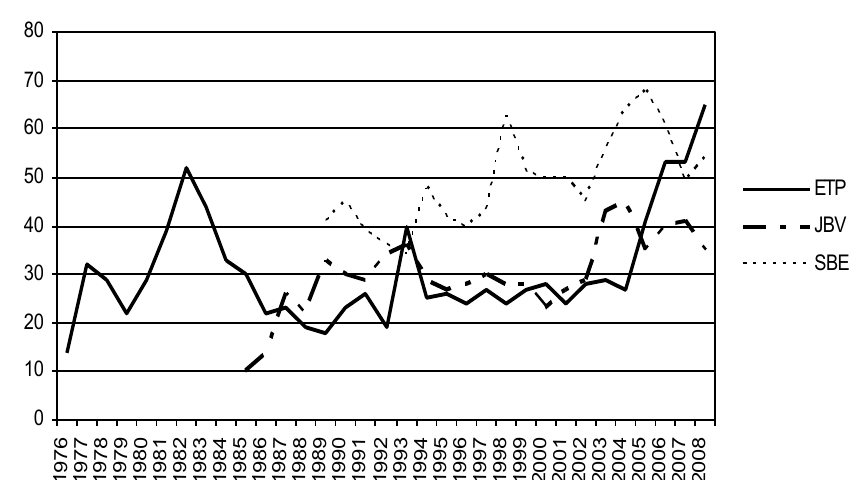
Fig. 2. Evolution of the number of articles per year published in ETP, JBV and SBE, 1976-2008 Source: Authors’ computations based on our sample of articles collected manually for ETP and from Social Sciences Citation Index (SSCI) of the ISI Web of Science, for JBV and SBE, (n=2716). The number of articles included in the years 1985 and 1986 for JBV, and 1989, 1990 and 1991 for SBE were collected manually, since they were unavailable in the ISI